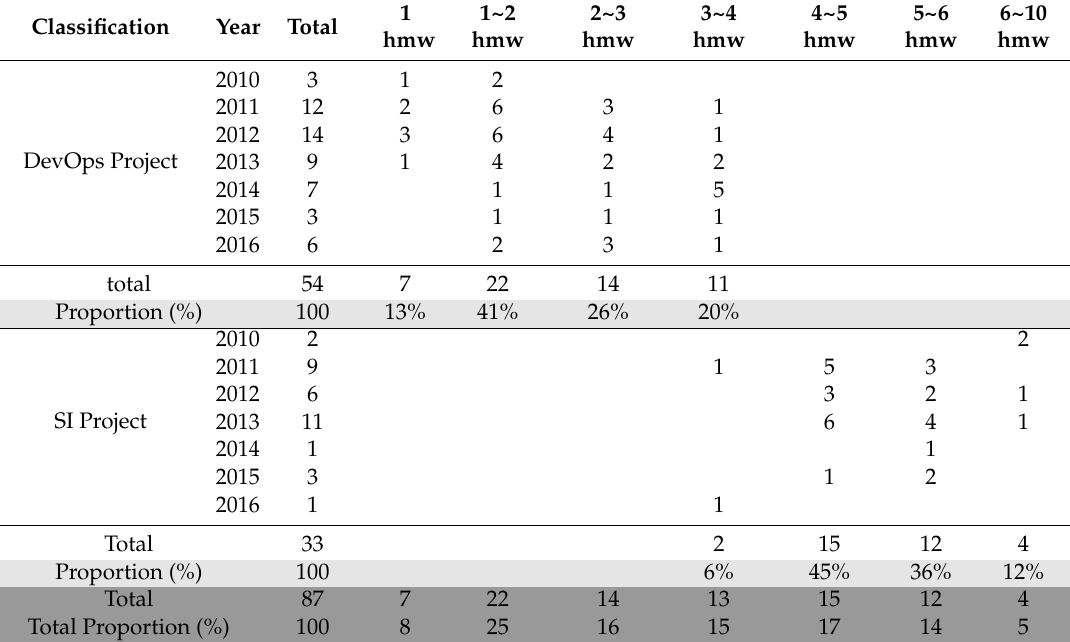
Table 5. The projects distinguished by year, project type, and contract amount.